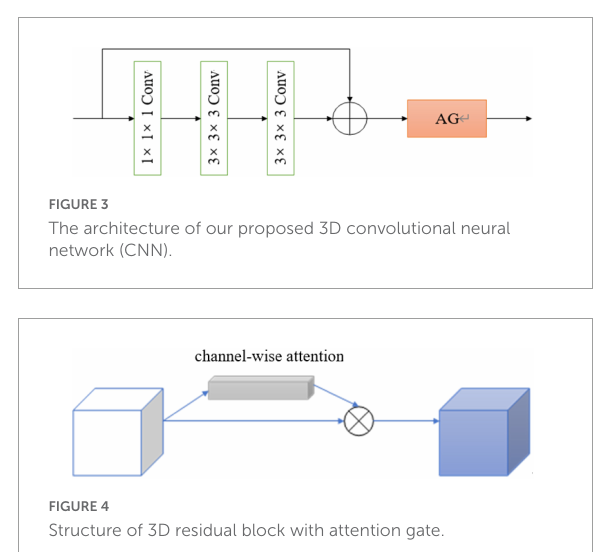
FIGURE4 Structure of 3D residual block with attention gate.